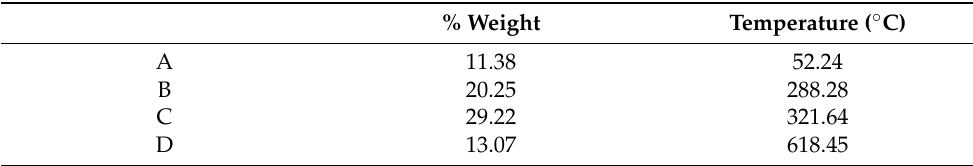
Table 2. Mass loss percentage.